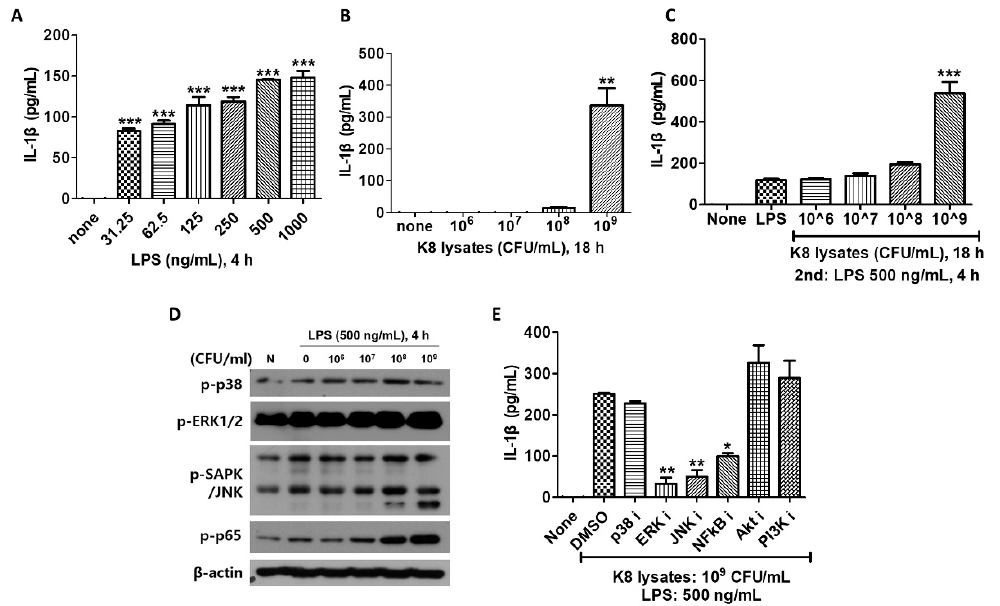
Figure 4. The production of IL-1 β was increased in THP-1 cells by L. plantarum K8 lysates and LPS combination treatment. ( A ) THP-1 cells were treated with LPS at the indicated concentrations for 4 h. ( B ) THP-1 cells were treated with L. plantarum K8 lysates from 1 × 10 6 to 1 × 10 9 CFU/mL for 18 h. ( C ) THP-1 cells were pretreated with L. plantarum K8 lysates at the indicated concentrations for 18 h and treated with 500 ng/mL LPS for 4 h. In ( A – C ), the IL-1 β level in the culture supernatants was determined using ELISA. ( D ) THP-1 cells were pretreated with indicated dose of L. plantarum K8 lysates for 18 h and then stimulated with 500 ng/mL LPS for 4 h. The protein levels of p-p38, p-ERK, p-SAPK/JNK, p-NF- κ B p65, and β -actin were measured in cell lysates by western blot. ( E ) THP-1 cells were pretreated with either DMSO or 10 µ M of inhibitors for 30 min. The cells were treated with 1 × 10 9 CFU/mL of L. plantarum K8 lysates for 18 h and 500 ng/mL LPS for 4 h. The IL-1 β level in the culture supernatants was determined using ELISA. Statistical analysis was conducted with one-way ANOVA followed by Tukey’s HSD post hoc test ( A – E ) and two-way ANOVA (G). * p < 0.05; ** p < 0.01; *** p <